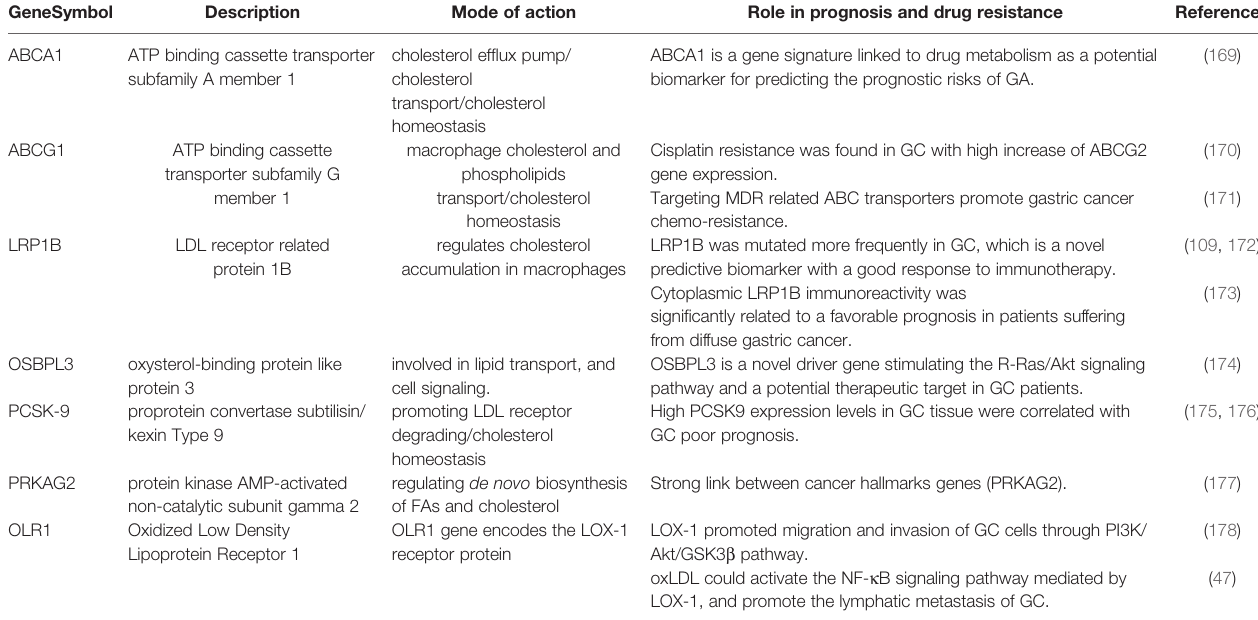
TABLE 3 | Summary of cholesterol related genes and their link to GC metastasis, EMT and/or drug resistance.